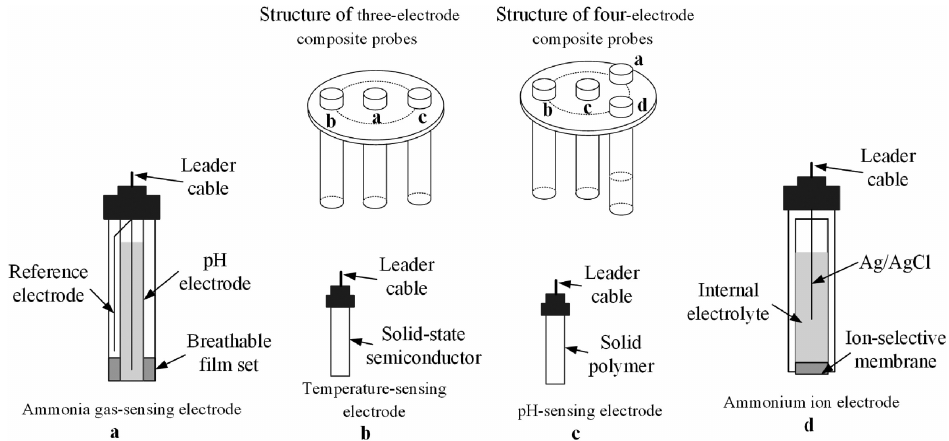
Figure 9. Type and structure of multi-parameter composite probes. [Reprinted with permission from ref.